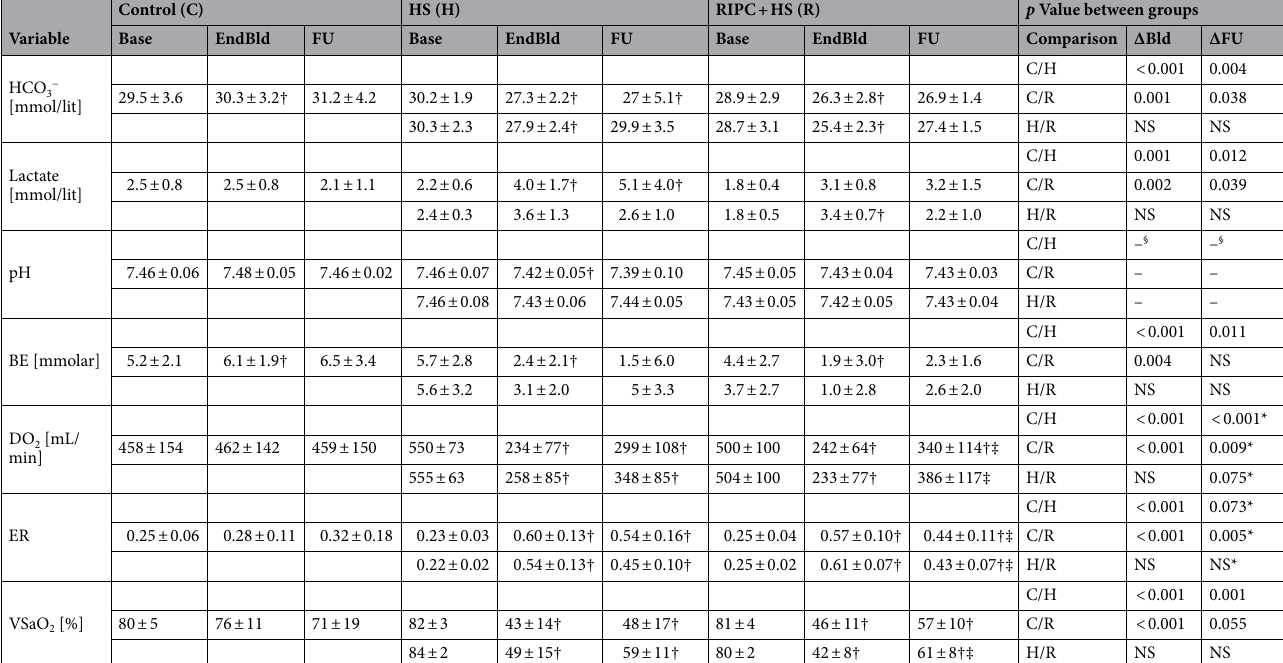
Table 2. Acid base and oxygen delivery. Data presented as mean ± SD. Numbers in first row of each parameter are for all animals. Numbers in second row of each parameter are only those that survived (6 h of follow-up: Controls, n = 7 at all time-points; HS, n = 13 at 2H, n = 10 at 4H, n = 9 at 6H; RIPC + HS, n = 8 at 2H and 4H, n = 5 at 6H). Normality was determined by Shapiro–Wilk (SW) test ( p > 0.1). Comparisons between baseline, end of bleeding [EndBld], and follow-up [FU] (mean over 7-h follow-up) within groups were performed by paired t-test with Bonferroni’s correction for multiple comparisons or Friedman’s test with pairwise comparisons as post-hoc test as appropriate (according to SW). Comparisons between groups (relates to all 7 h) were performed by analysis of variance (ANOVA) with Fisher’s least significance difference (FLSD) as post- hoc test or Kruskal–Wallis (KW) with Conover-Iman as post-hoc testHCO 3 − = Bicarbonate, BE = Base Excess; DO 2 = Delivered Oxygen, ER = Oxygen Extraction Ratio, VSaO 2 = Mixed venous saturation. ΔBld = (EndBld- Baseline), ΔFU = (FU-EndBld), *ΔFU = (FU-Baseline). p < 0.05 considered significant and all tests 2-tailed. † p < 0.05 versus baseline; ‡ p < 0.05 versus EndBld; § not significant by